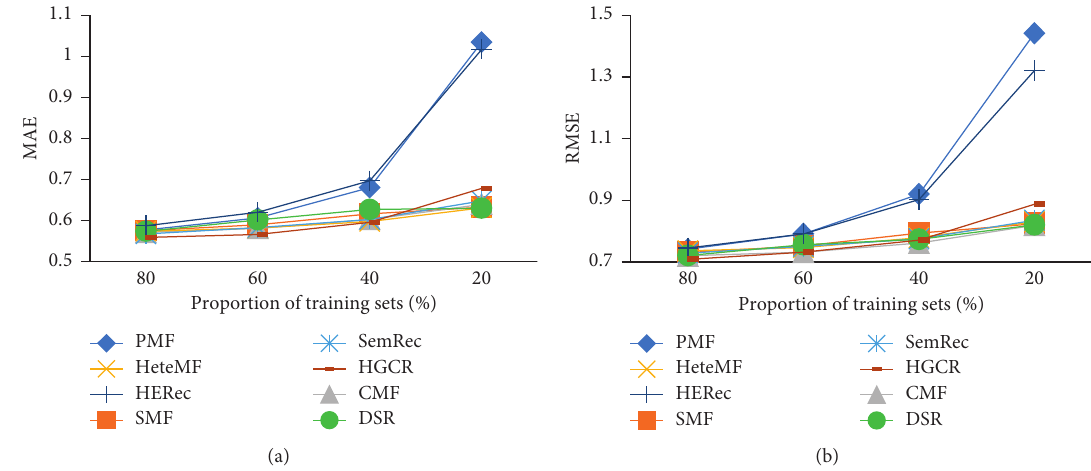
Figure 5: Performance of Douban Book with different algorithms. (a) MAE vs. proportion of training sets. (b) RMSE vs. proportion of training sets.